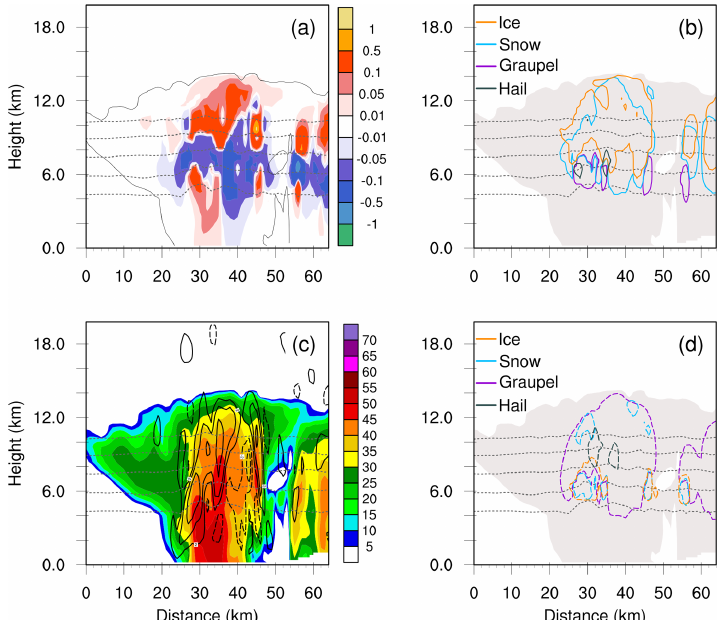
Figure 15. As in Fig. 14 but for the vertical cross sections at the location shown in Fig. 4c of simulated variables at the mature stage of the thunderstorm (11:24UTC) in the C